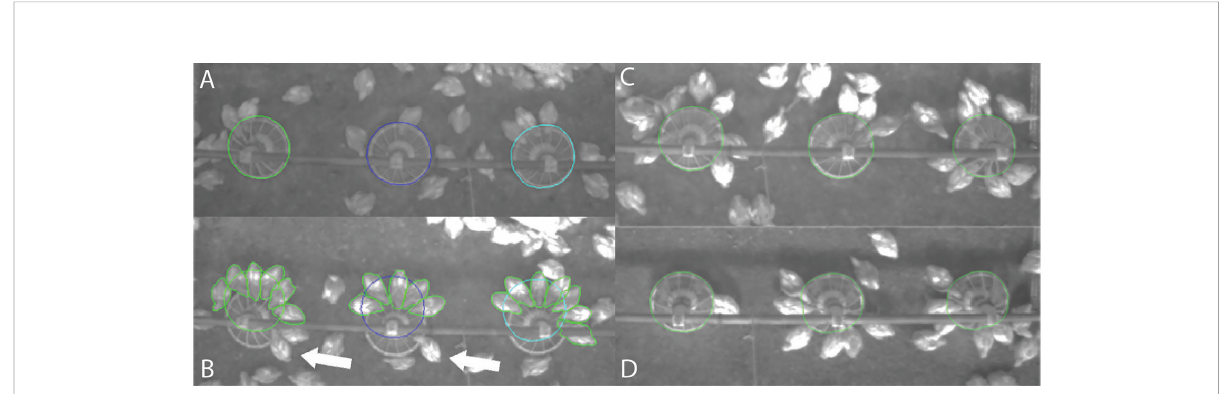
FIGURE 3 (A) De fi ned static feeder region of interest (ROI) indicated by green, dark blue and light blue circles, (B) moved feeders where some chicks are not assigned to the static feeder ROI (indicated with arrows), (C, D) automatically detected (dynamic) feeders with